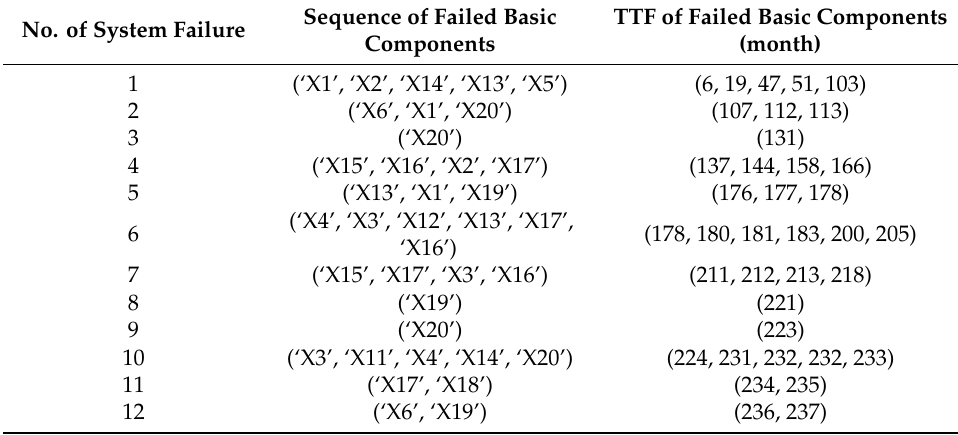
Table 6. Results of simulated TTFs and sequence of failure components in one